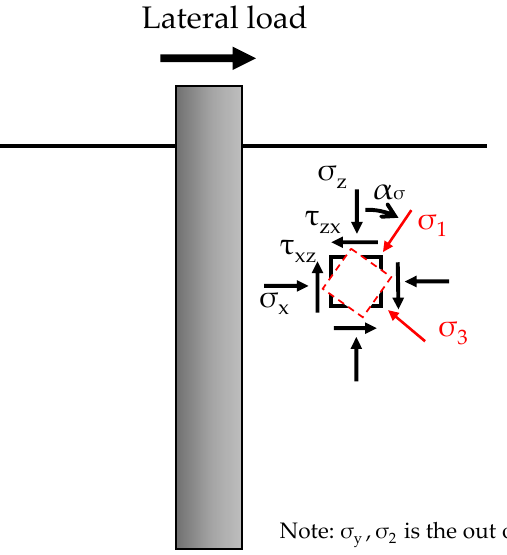
Figure 4. Considered stress components in the analysis.